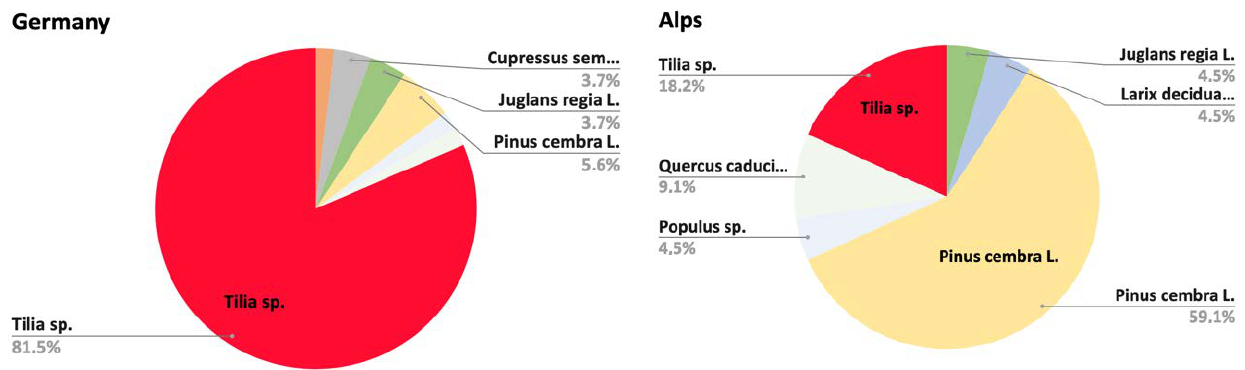
Figure 7. Distribution of timbers in artworks from German ( left ) and Alpine ( right ) cultural